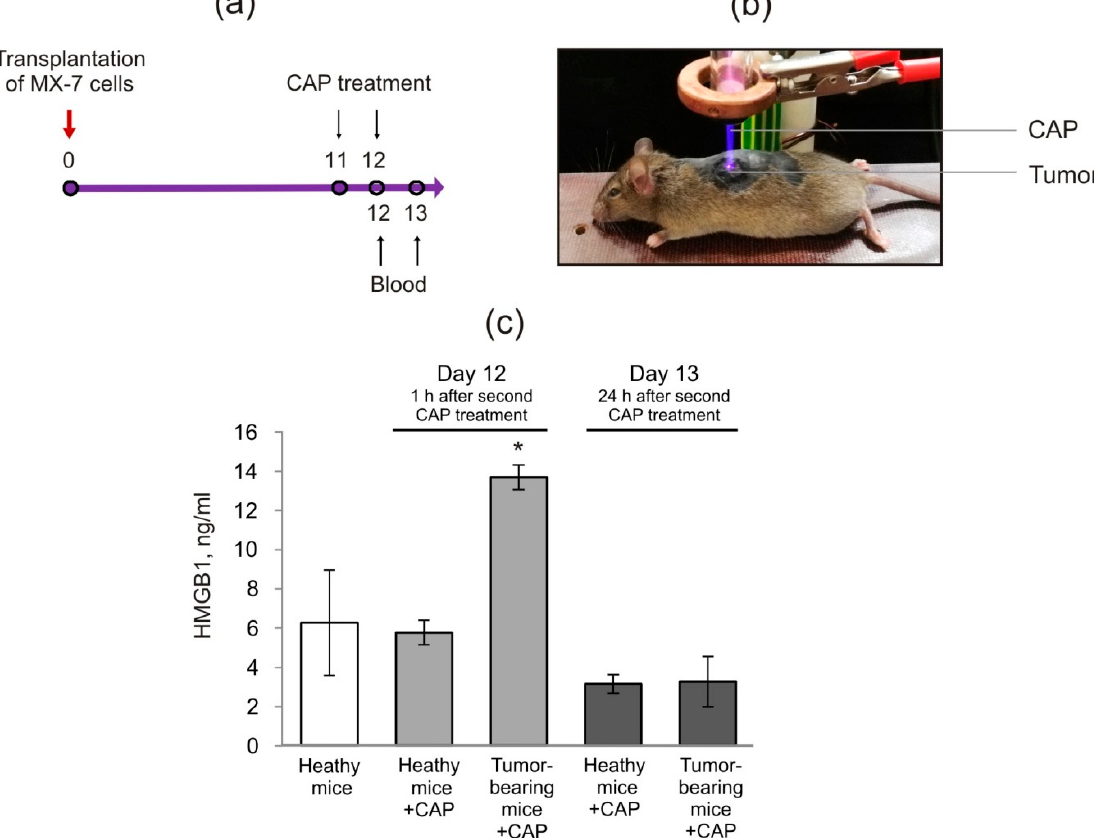
Figure 5. The influence of CAP irradiation on the serum HMGB1 in healthy and tumor-bearing mice. ( a ) Scheme of the experiment. C3H/He mice were inoculated subcutaneously with 5*10 5 MX − 7 cells. ( b ) Image of mouse irradiation. ( c ) Serum HMGB1 amount. Data are presented as the mean ± SEM ( n = 5). The differences were calculated using the Student’s t-test and these were significant with p < 0.05 (*).